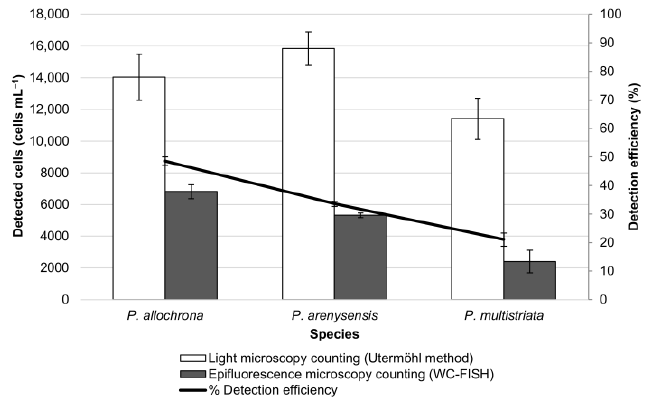
Figure 5. Simulated natural sample composed of three Pseudo-nitzschia species. Cell density (cells mL −1 ) was estimated before and after WC-FISH. The detection efficiency (%) of the WC-FISH is calculated by the ratio between epifluorescence counting vs. light microscopy counting.